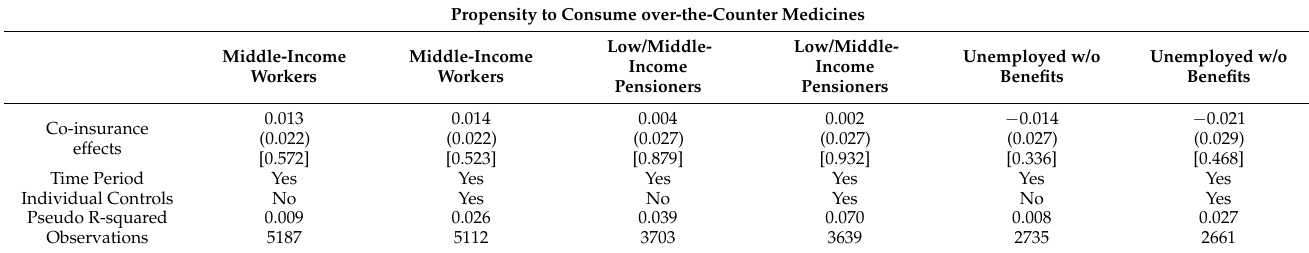
Table A2. Results for the propensity to consume OTC medicines using non-linear estimation method (logit).